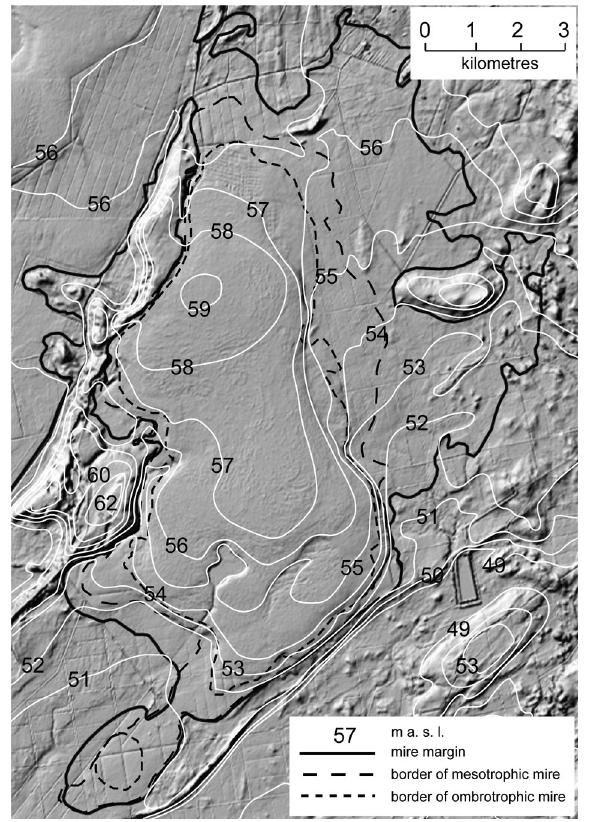
Fig. 3. Lidar-based digital elevation model (DEM) of the Selisoo mire area. The terrain is gently sloping southwards. The former coastline of Lake Seli is distinguishable in the southern part of the